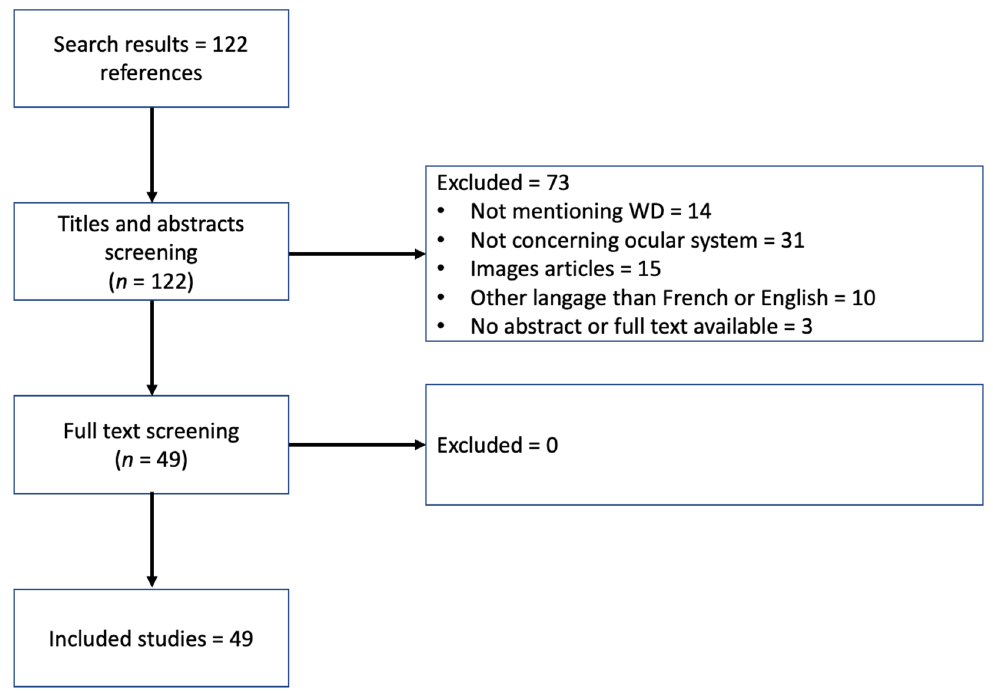
Figure 1. Flow-chart of the literature review. WD: Wilson’s Disease.